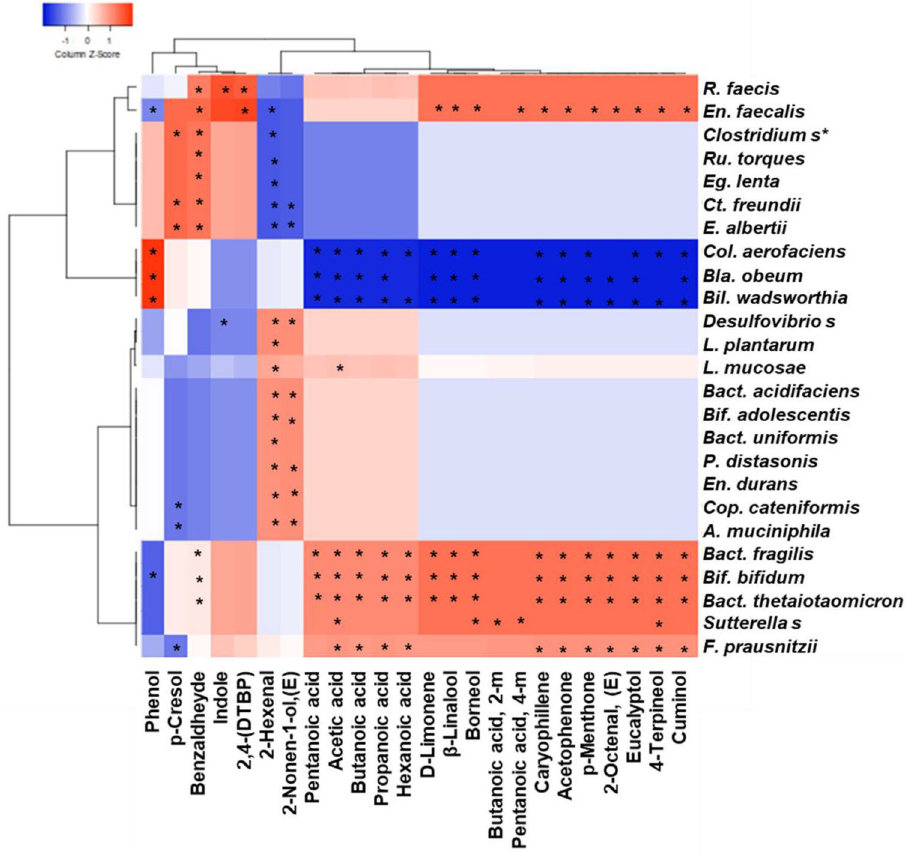
Figure 5. Interomics, Spearman Rank Correlations from the HBPA datasets related to microbial metabolites of the volatilome and species OTUs from the microbiota. Left side dendrogram identifies by Pearson analysis three major different clusters among bacterial species. Heat map was generated with the Expression tool on http:// www. heatm apper. ca/ expre ssion/ (last accessed on 2 January 2023). Significance of correlations are provided as supplementary material (Table